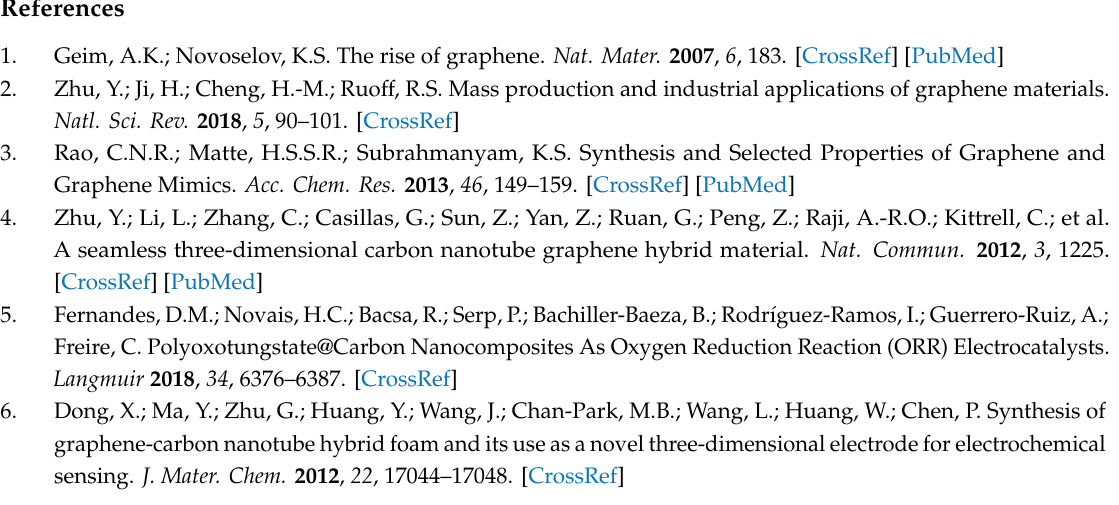
Figure S1: Powder X-ray di ff ractograms of CoFe 2 O 4 , Al 0.1 Co 0.9 Fe 2 O 4 , and AlCoFeO 4 catalysts after calcination at 800 ◦ C, Figure S2: ( a ) High-resolution TEM micrograph of the FLG-CNT hybrid (scale bar = 10 nm) and ( b ) electron di ff raction pattern of the FLG portion, showing its crystalline nature and rotated graphene planes, as previously reported [1], Figure S3: TEM micrograph of the hybrid material grown from a single catalyst with 10 mol % Al (Al 0.1 Co 0.9 Fe 2 O 4 ) (scale bar = 100 nm)—method-3. Well-graphitized large spheres are seen along with CNTs, Figure S4: ( a ) TGA curves and ( b ) TGA first derivative in air atmosphere for CNTs, FLG, and FLG-CNT hybrids obtained from both single catalyst and mixed